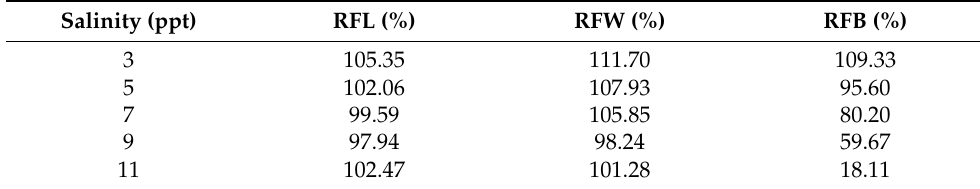
Table 2. Final relative average total length, average weight and biomass of asp larvae Leuciscus aspius (L.) obtained in rearing on natural feed in water with various salinity levels. Salinity